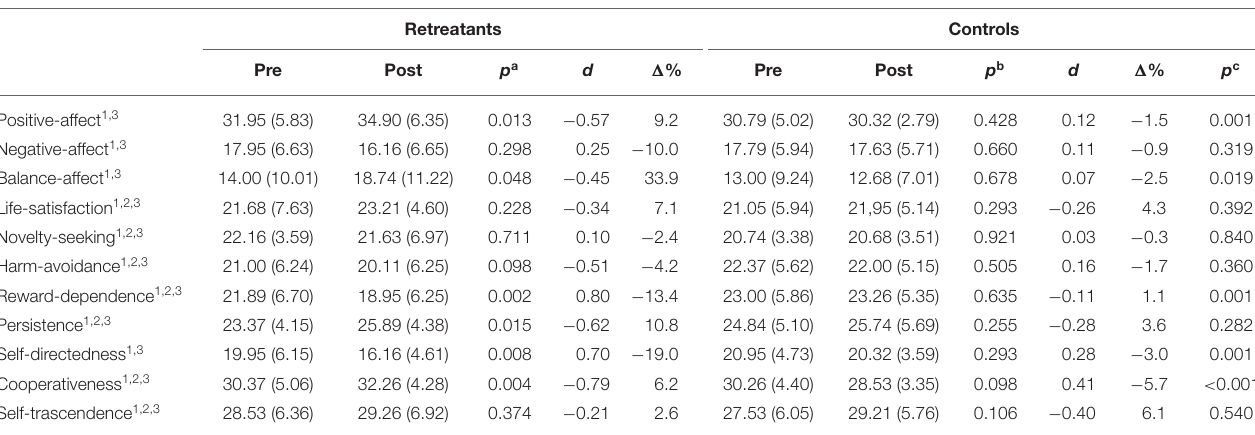
TABLE 3 | Meditation retreat effects on well-being and